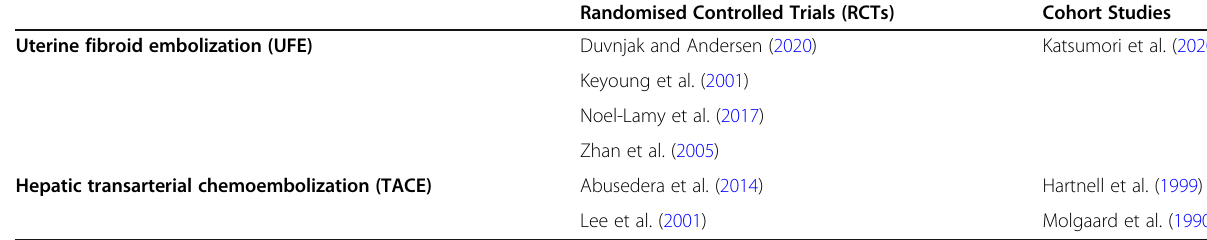
Table 1 A table summarising the studies included in this review and the embolization procedures that they